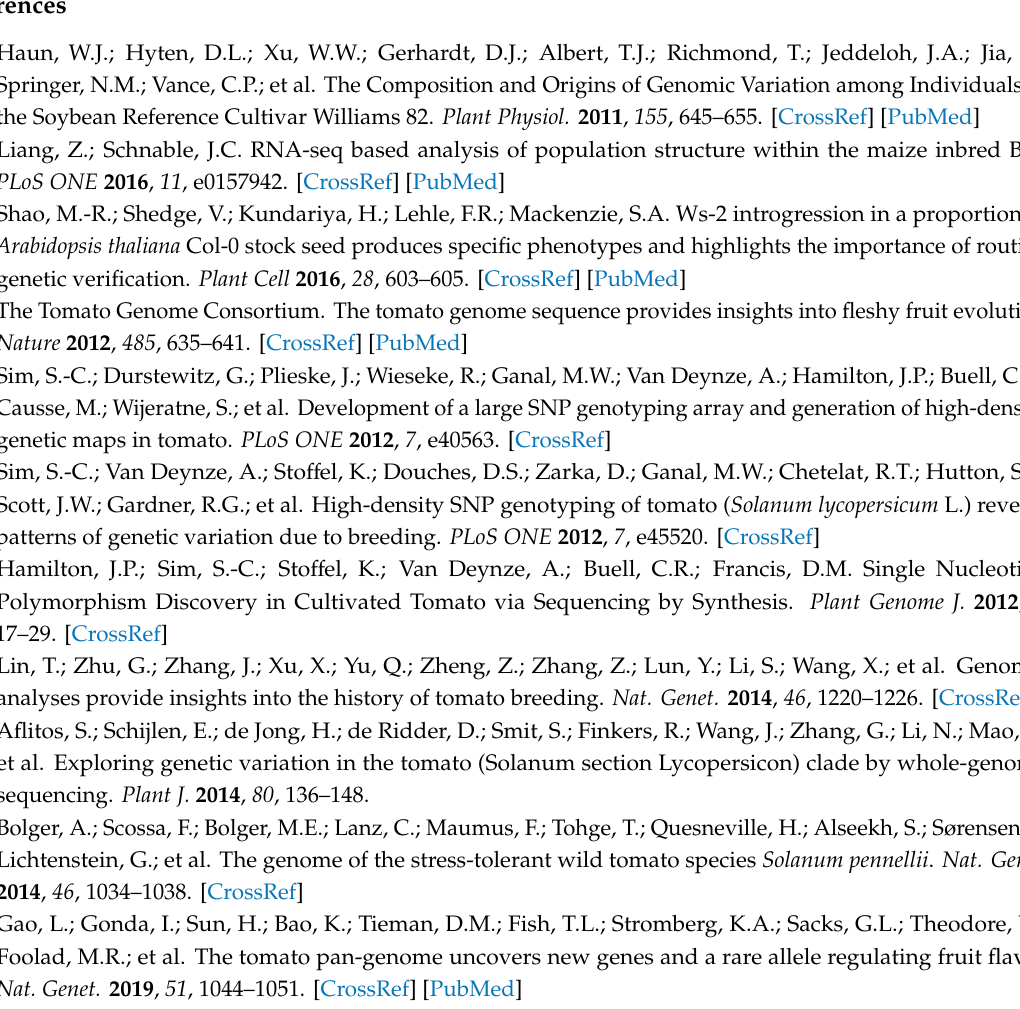
Table S1. Plant material description and sourced of samples, Table S2: Pairwise comparison by chromosome (Ch) using a set of 32,352 robust SNPs for ‘M82’ sequence samples: M82-ERS484046, M82-TS228, M82-TS3, Table S3: Pairwise comparison by chromosome (Ch) using a set of 32,352 robust SNPs for ‘M82’ and ‘UC 82’ sequence samples: M82-ERS484046, M82-TS228, M82-TS3, and UC 82-TS171, Figure S1: Cluster dendrogram based on SNPs extracted from the SolCAP data set. The accessions ‘Heinz 1706’ (gold-standard reference) and the Solanum pimpinellifollium LA1589 were used as outgroups for the